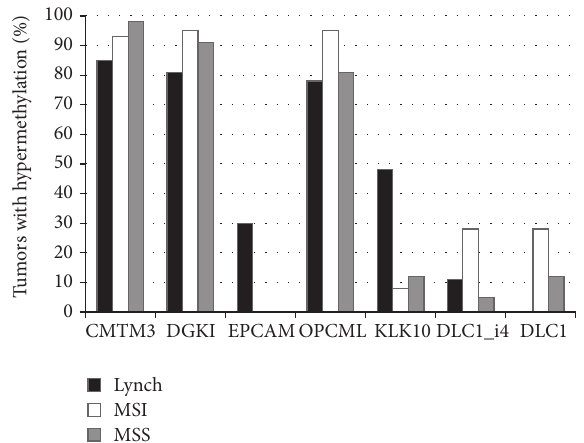
Figure 4: Frequency of promoter hypermethylation for all selected genes in the three categories of tumors. 𝑦 -axis indicates the percent- age of tumors showing hypermethylation, based on cut-off values given in Supplementary Table